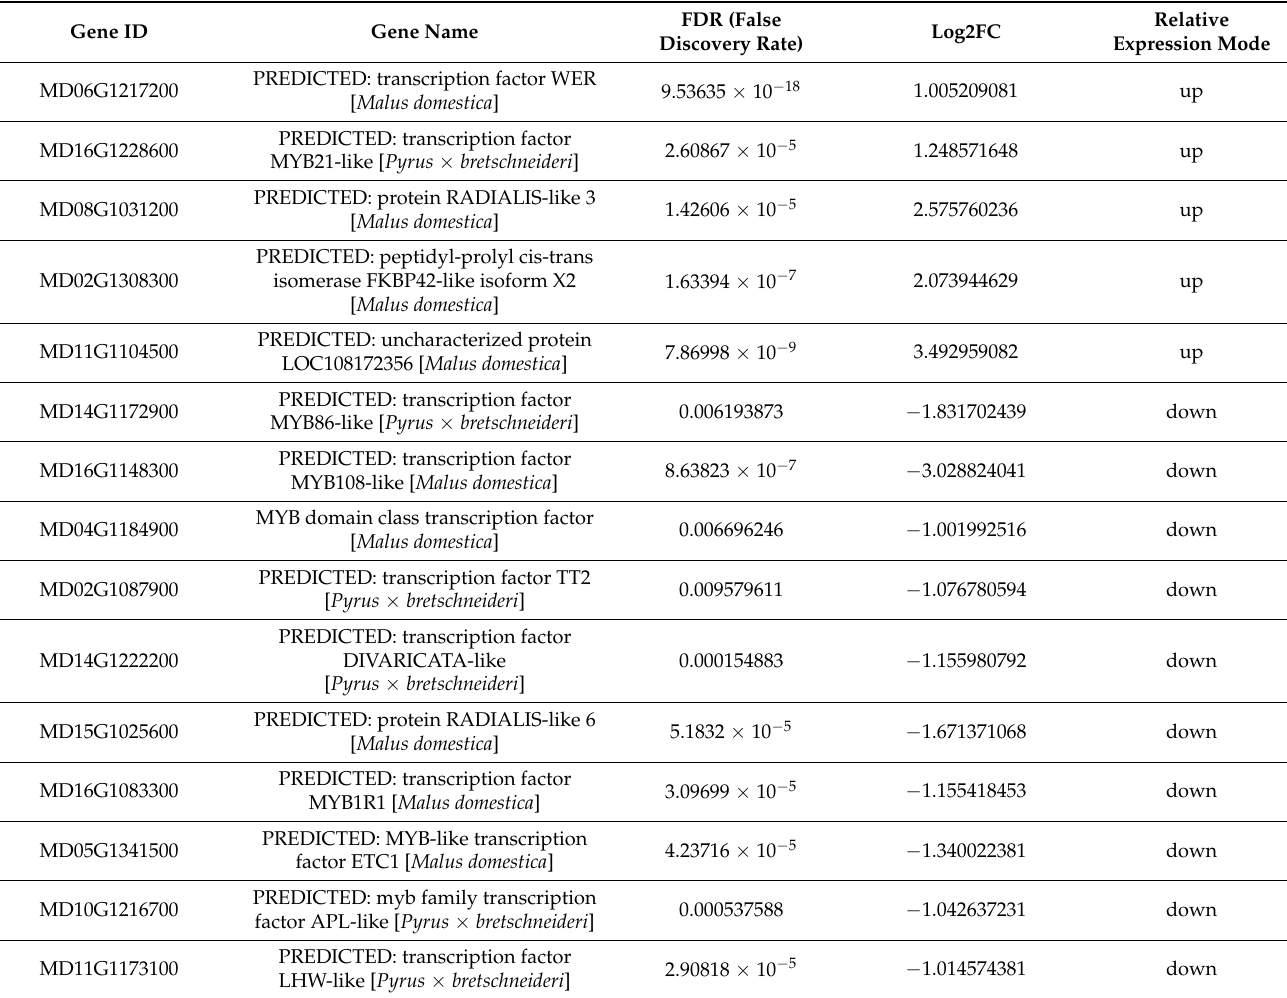
Table 2. Differentially expressed b-ZIP transcription factors in LF and GLF fruit.